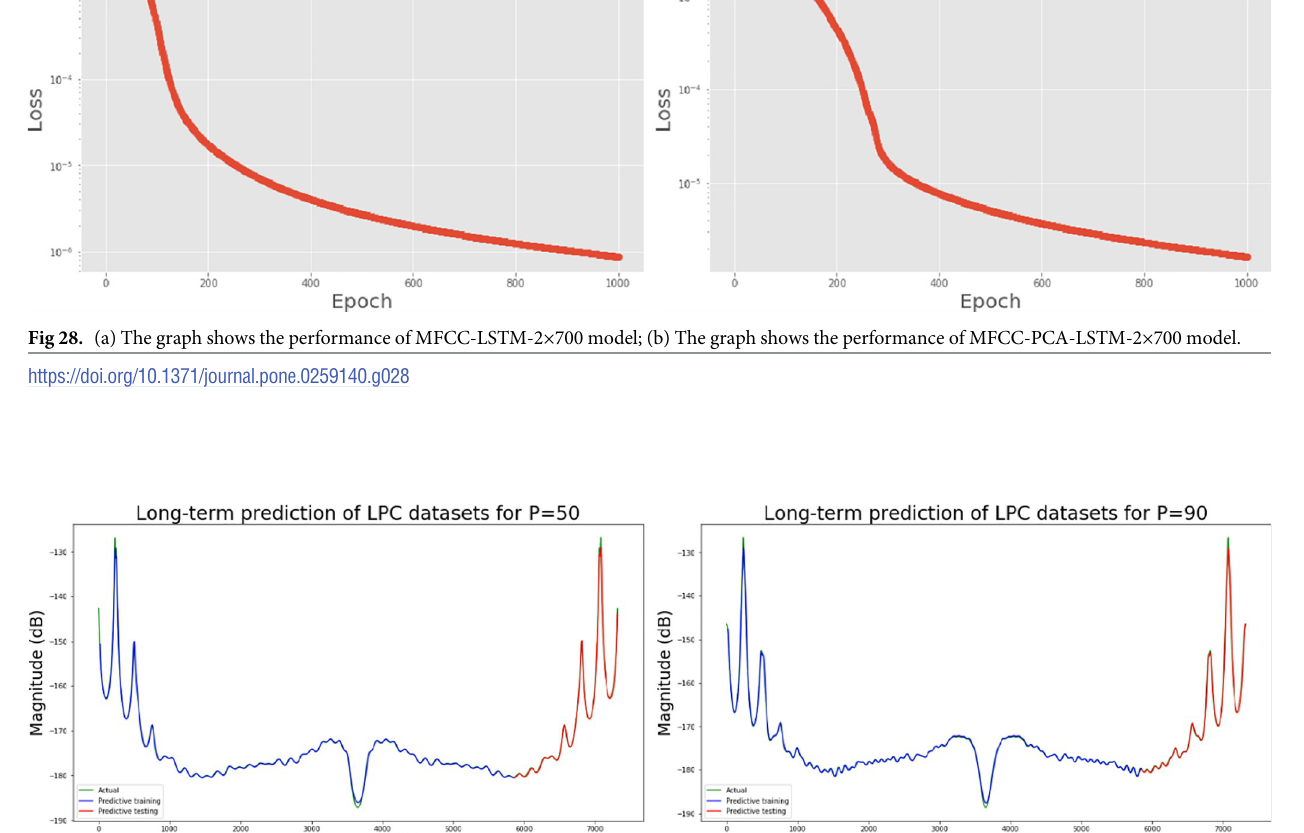
PLOS ONE | https://doi.org/10.1371/journal.pone.0259140 December23, 2021 21 /